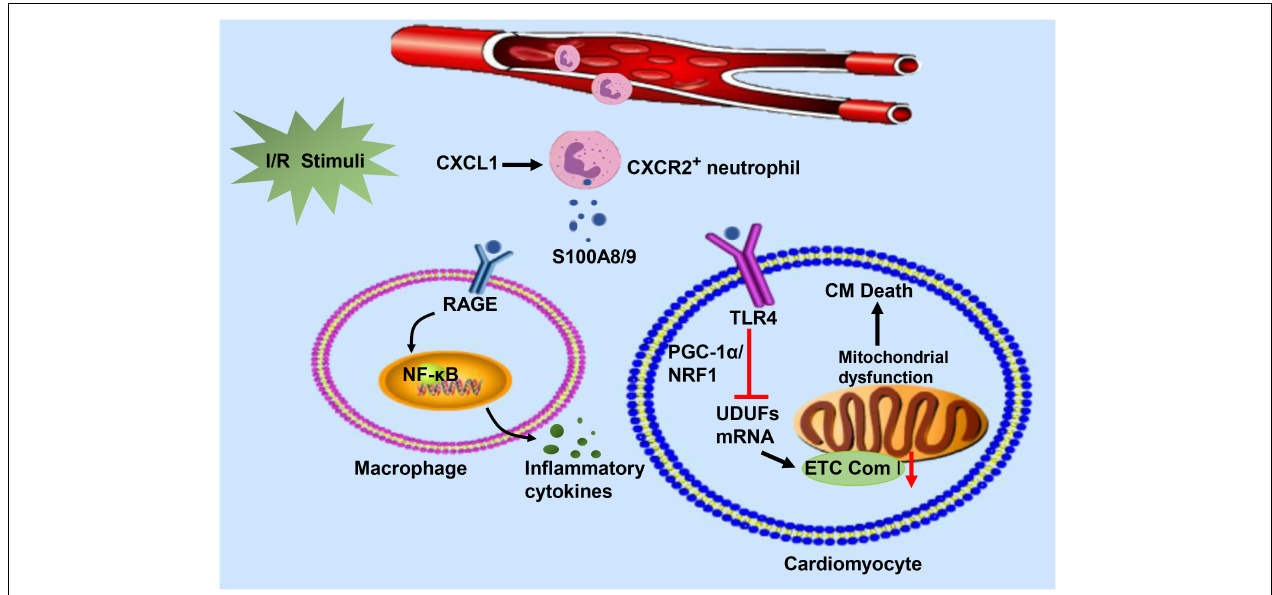
FIGURE 3 | In response to I/R injury, neutrophils migrate from the circulation to the injured heart in response to CXCL and release S100A8/A9. The heterodimeric complex binds to RAGE on the surface of immune cells and stimulates immune cells to secrete inflammatory cytokines by activating the NF- κ B signaling pathway. On the other hand, S100A8/A9 interacts with TLR-4 to inhibit NDUFs gene expression by suppressing the PGC-1/NRF1 signaling pathway, which decreases cardiac mitochondria electron transport chain (ETC) complex I activity. Mitochondrial dysfunction eventually leads to the death of